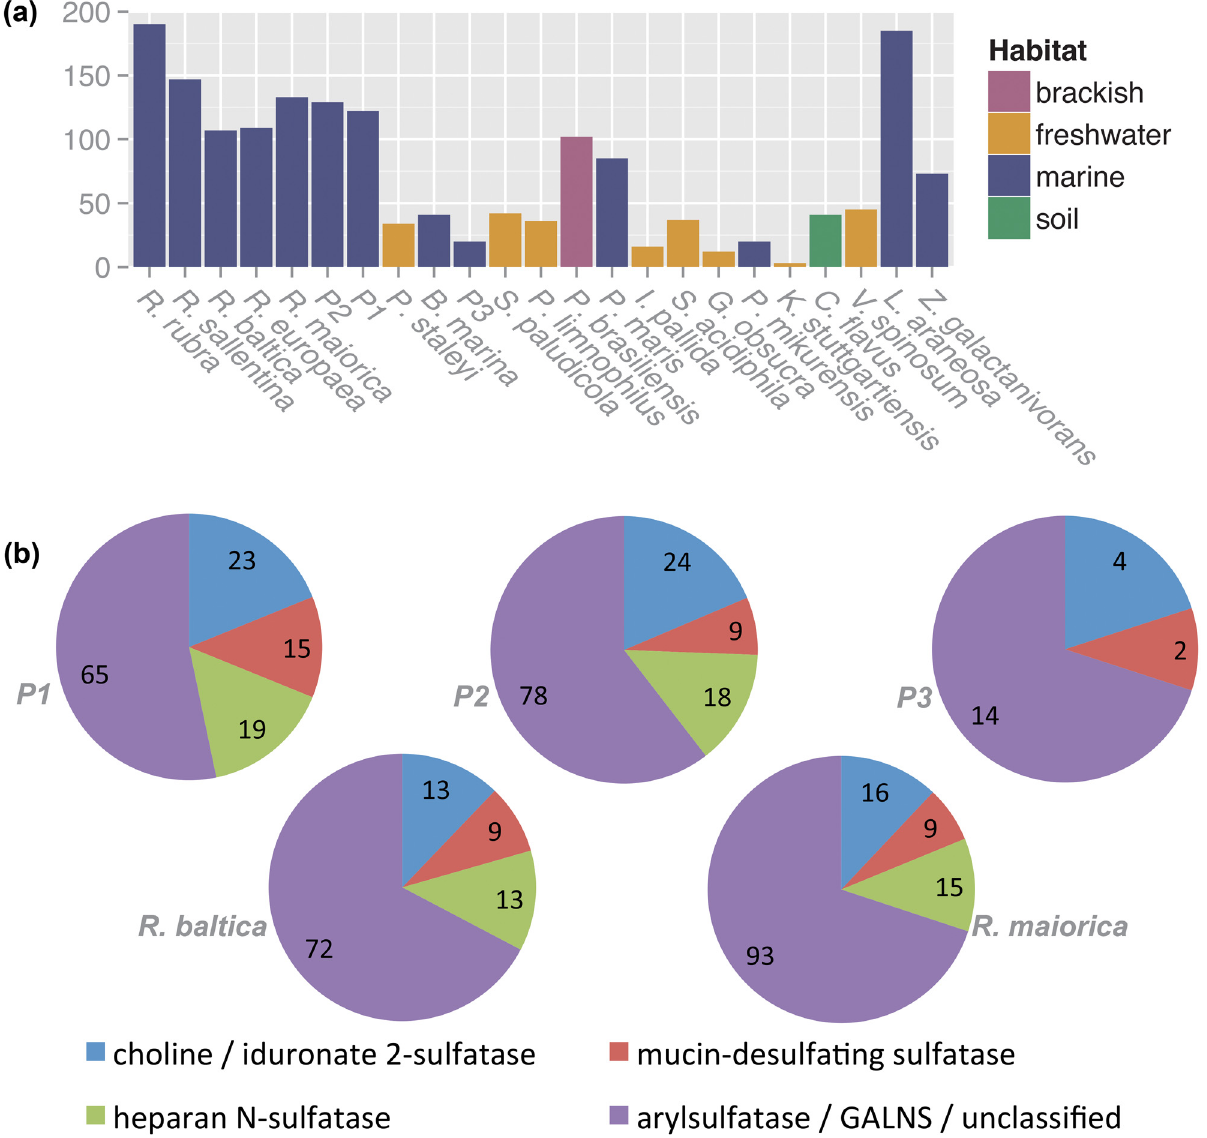
Fig 3. Sulfatase gene distribution and sub-classification in Planctomycetes and related strains. (a) Number of sulfatase genes in various Planctomycetes and related strains. Only sulfatase genes encoding the active site and (cid:1) 350 amino acid residues were included. (b) Functional subclasses of sulfatases present in P1, P2, P3, R . baltica and R . maiorica . For each organism, the total number of sulfatases ( (cid:1) 350 residues) is divided into the following subclasses: choline/ iduronate-2-sulfatases, mucin-desulfating sulfatases, heparan-N-sulfatases, and unclassified sulfatases including general arylsulfatases and galactosamine N- acetyl-6-sulfate